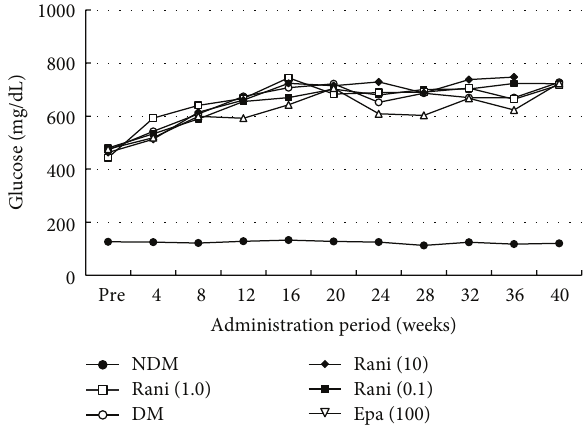
Figure 2: Plasma glucose levels during the experiment. The mean plasmaglucoselevelsoftheSDratsaresignificantlylowerthanthose of the SDT rats with or without treatment. There is no significant difference in the plasma levels among the SDT rats with or without treatment.NDM:non-diabetesmellitus;DM:diabetesmellitus;rani: ranirestat; epa: epalrestat.